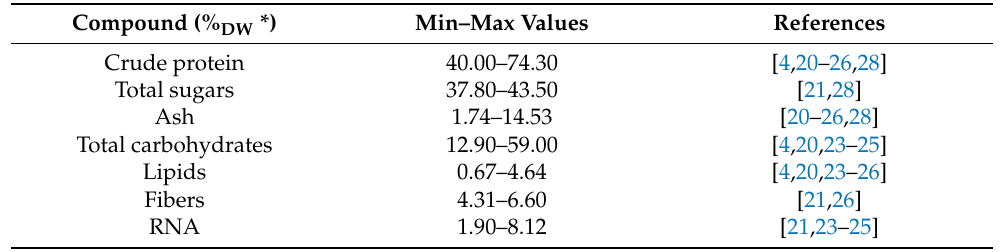
Table 2. Chemical composition of SBY expressed as the minimum (min) and maximum (max) of the results taken from the